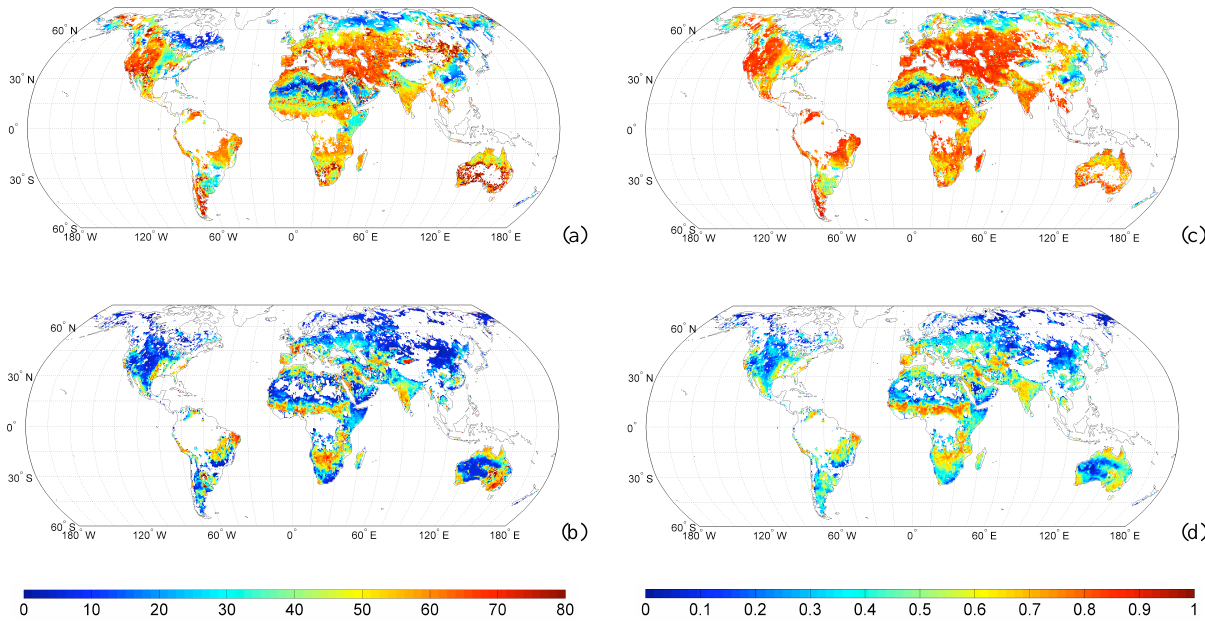
Fig. 7. Global characteristic lag-time (days) for ORCHIDEE ROOT SM (a) and AMSR-E (LPRM) (b) , as well as the autocorrelation value at a 20-day lag for ORCHIDEE ROOT SM (c) and AMSR-E (LPRM) (d)